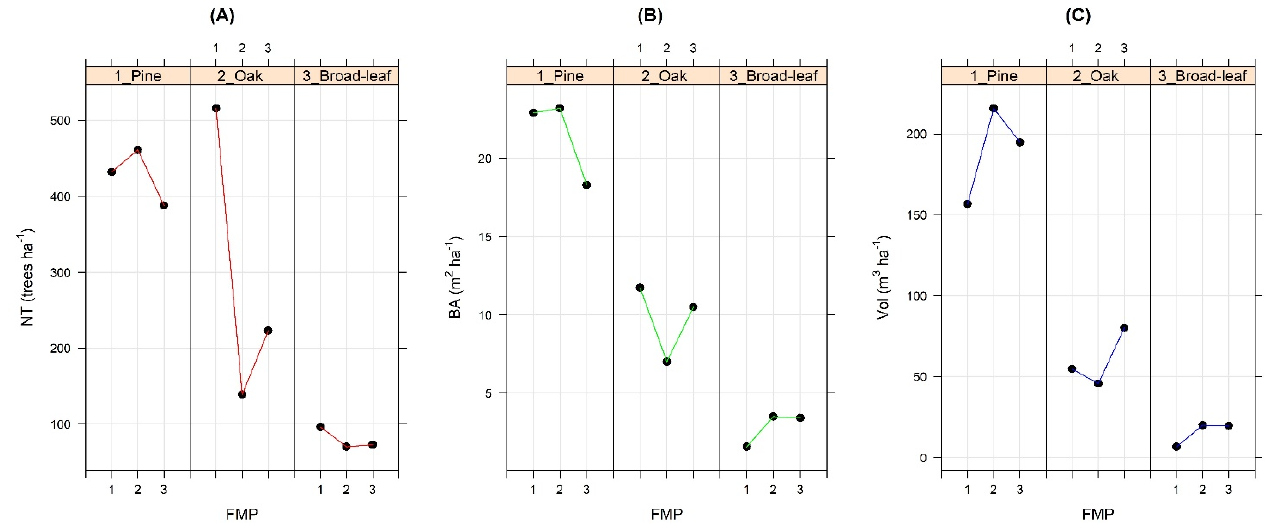
Figure 4. Comparison of number of trees ( NT ) ( A ), basal area ( BA ) ( B ), and volume ( Vol ) ( C ) of the three forest management plans (FMPs) in the G0107 sub-stand.